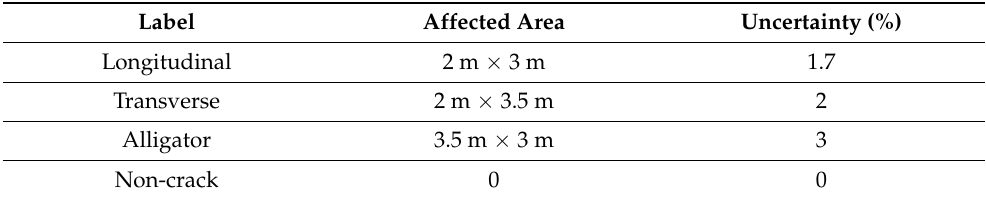
Table 6. Uncertainty associated with each classification hypothesis in road sections with 100 m width.